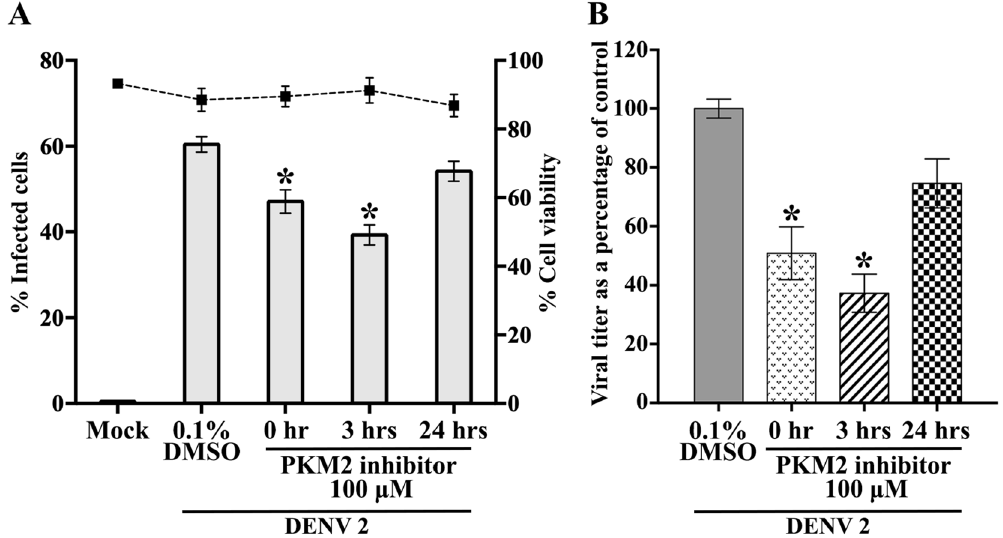
Figure 4. Effect of post-addition of pyruvate kinase M2 inhibitor on DENV 2 infection. U937 cells were incubated with 100 μM PKM2 inhibitor or with vehicle only or not treated at 0, 3 and 24 h after mock infection or infection with DENV 2. ( A ) Cells were collected to determine the cell viability by trypan blue staining and infection level by flow cytometry or ( B ) Supernatants were collected to determine virus titer by standard plaque assay. Experiments were undertaken independently in triplicate with duplicate plaque assay. Bars show mean ± SEM (* P value <